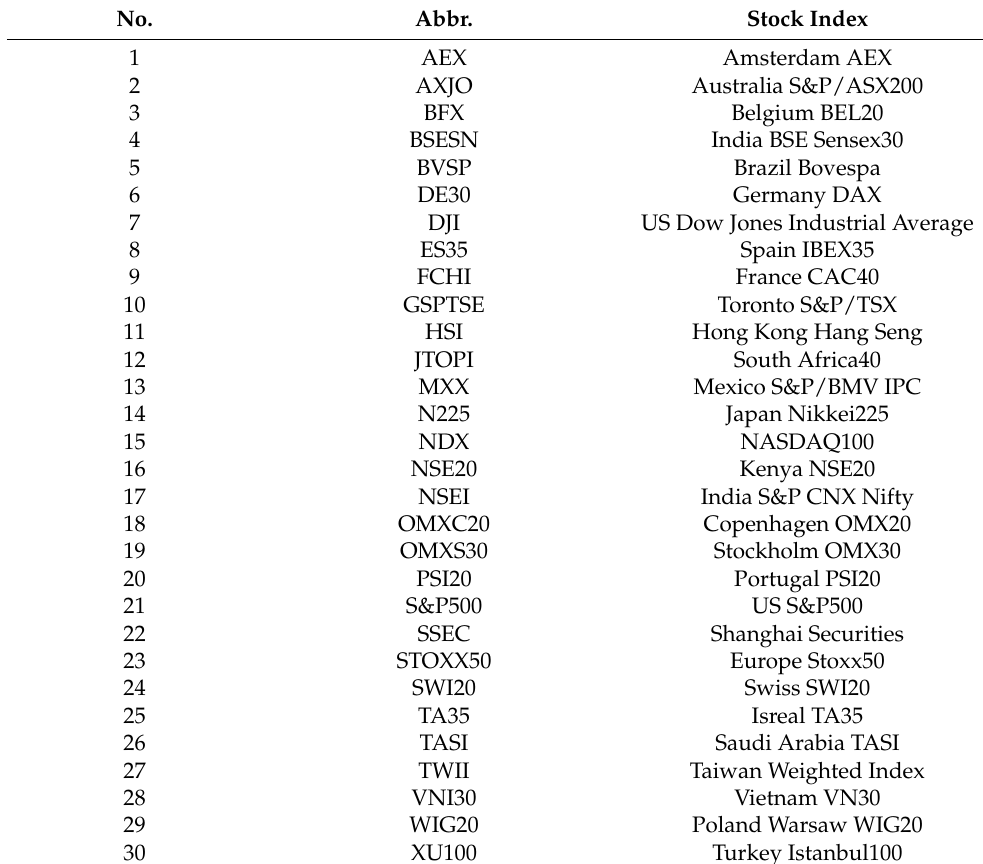
Table 1. A Selection of Global Major Stock Indices.